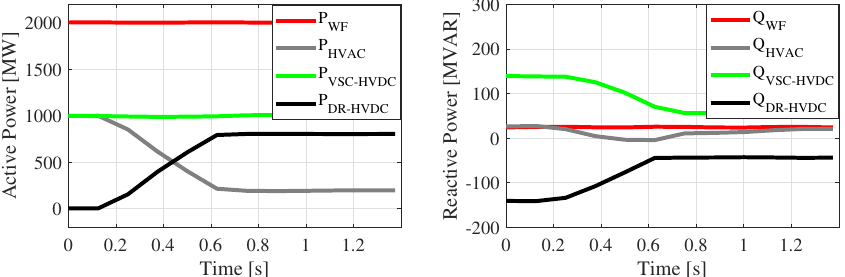
Figure 19. Active ( left ) and reactive ( right ) power of OWF and transmission systems during the power ramp-up of